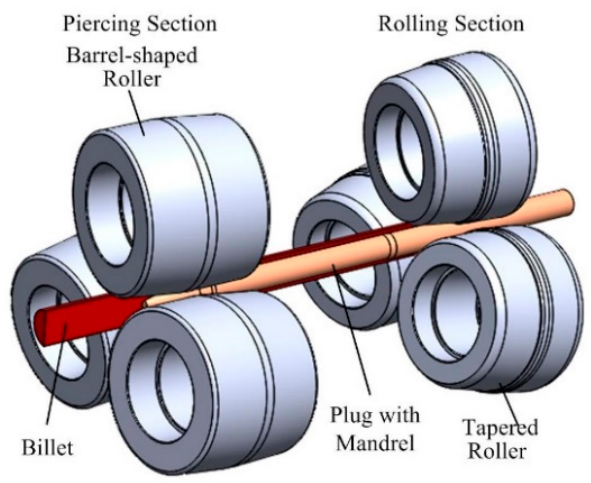
Figure 24. Process principle of tandem skew rolling [36] (Reprinted from ref. [36]).